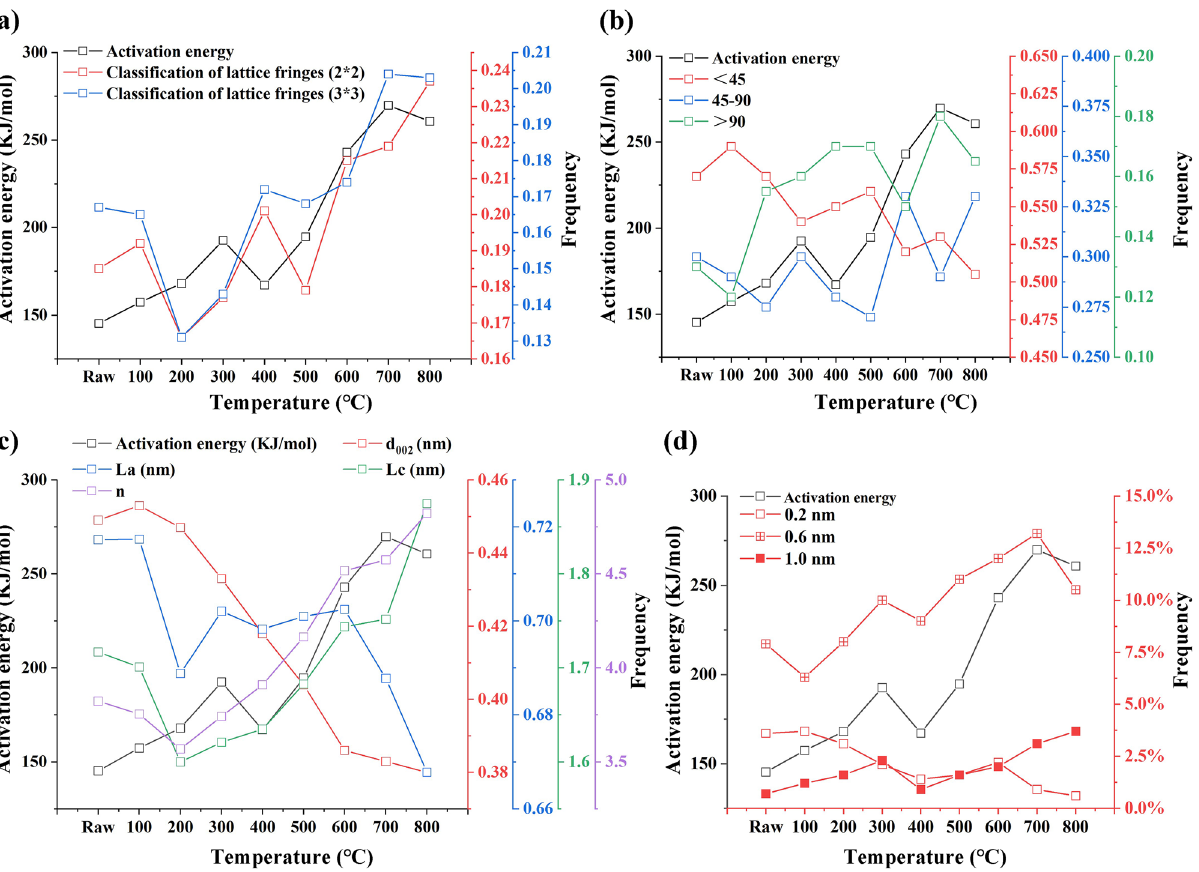
Figure 8. Activation energy of heat treatments. ( a : activation energy values with classification of lattice fringes, b : activation energy values with the cumulative angle, c : activation energy values with the stack structure, d : activation energy values with the pore